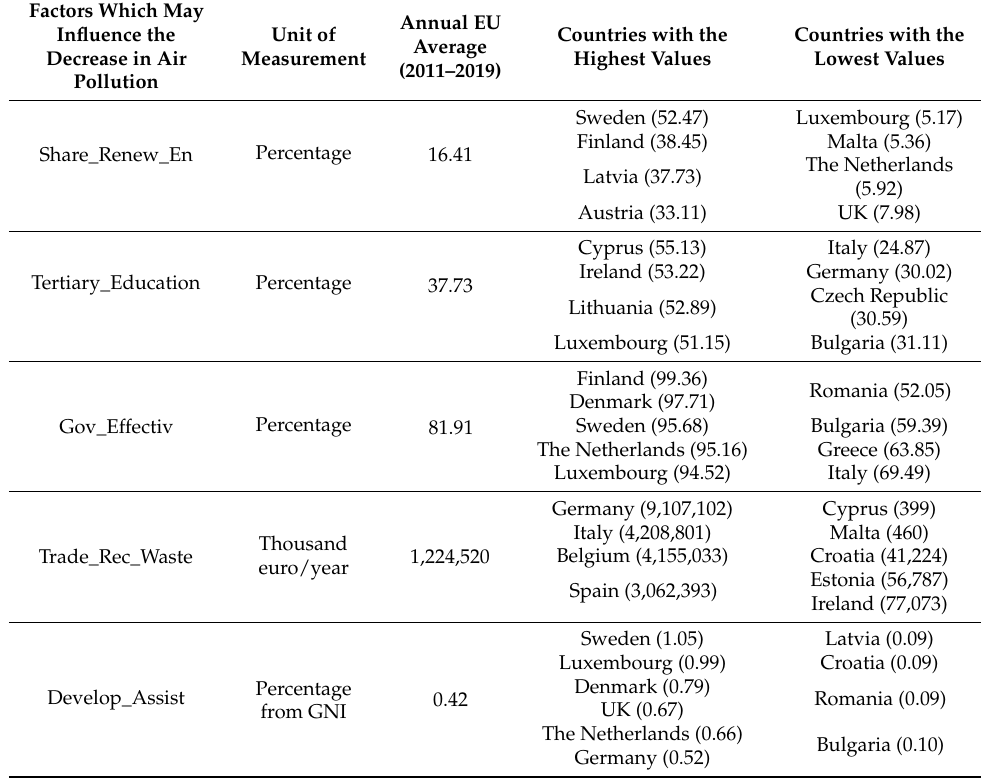
Table 6. The countries with the highest/lowest values in terms of the quantity of air pollution. Factors Which May Influence